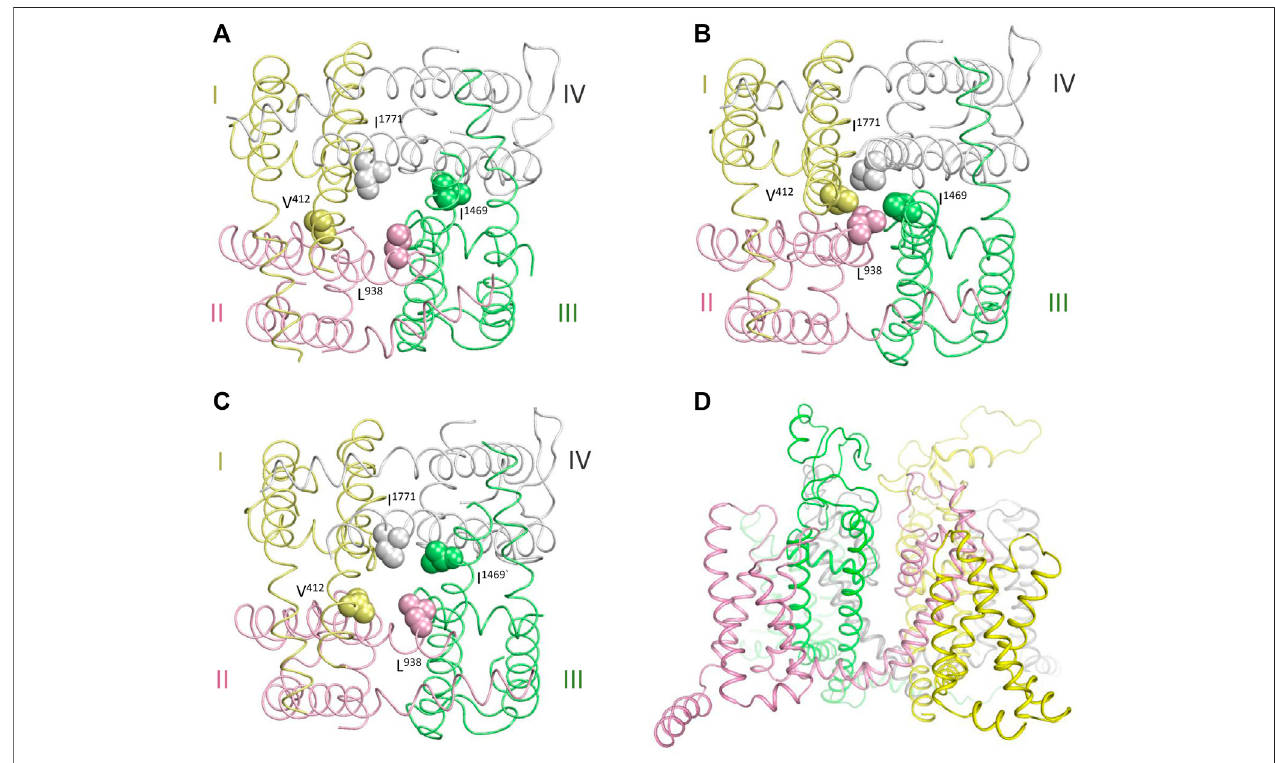
FIGURE 3 | Cryo-EM structure and homology model of the hNav1.5 channel. Repeats I,II, III and IV are yellow, pink, green and gray, respectively. (A, C) Cytoplasmic views at the pore domain in the cryo-EM structure (A) , and NavAb-based models of the channel states with the closed (B) and open (C) pore domain. Space- fi lled residues at the cytoplasmic ends of S6 helices highlight different dimensions of the activated gate. (D) Intra-membrane view of the channel model with the open PD.